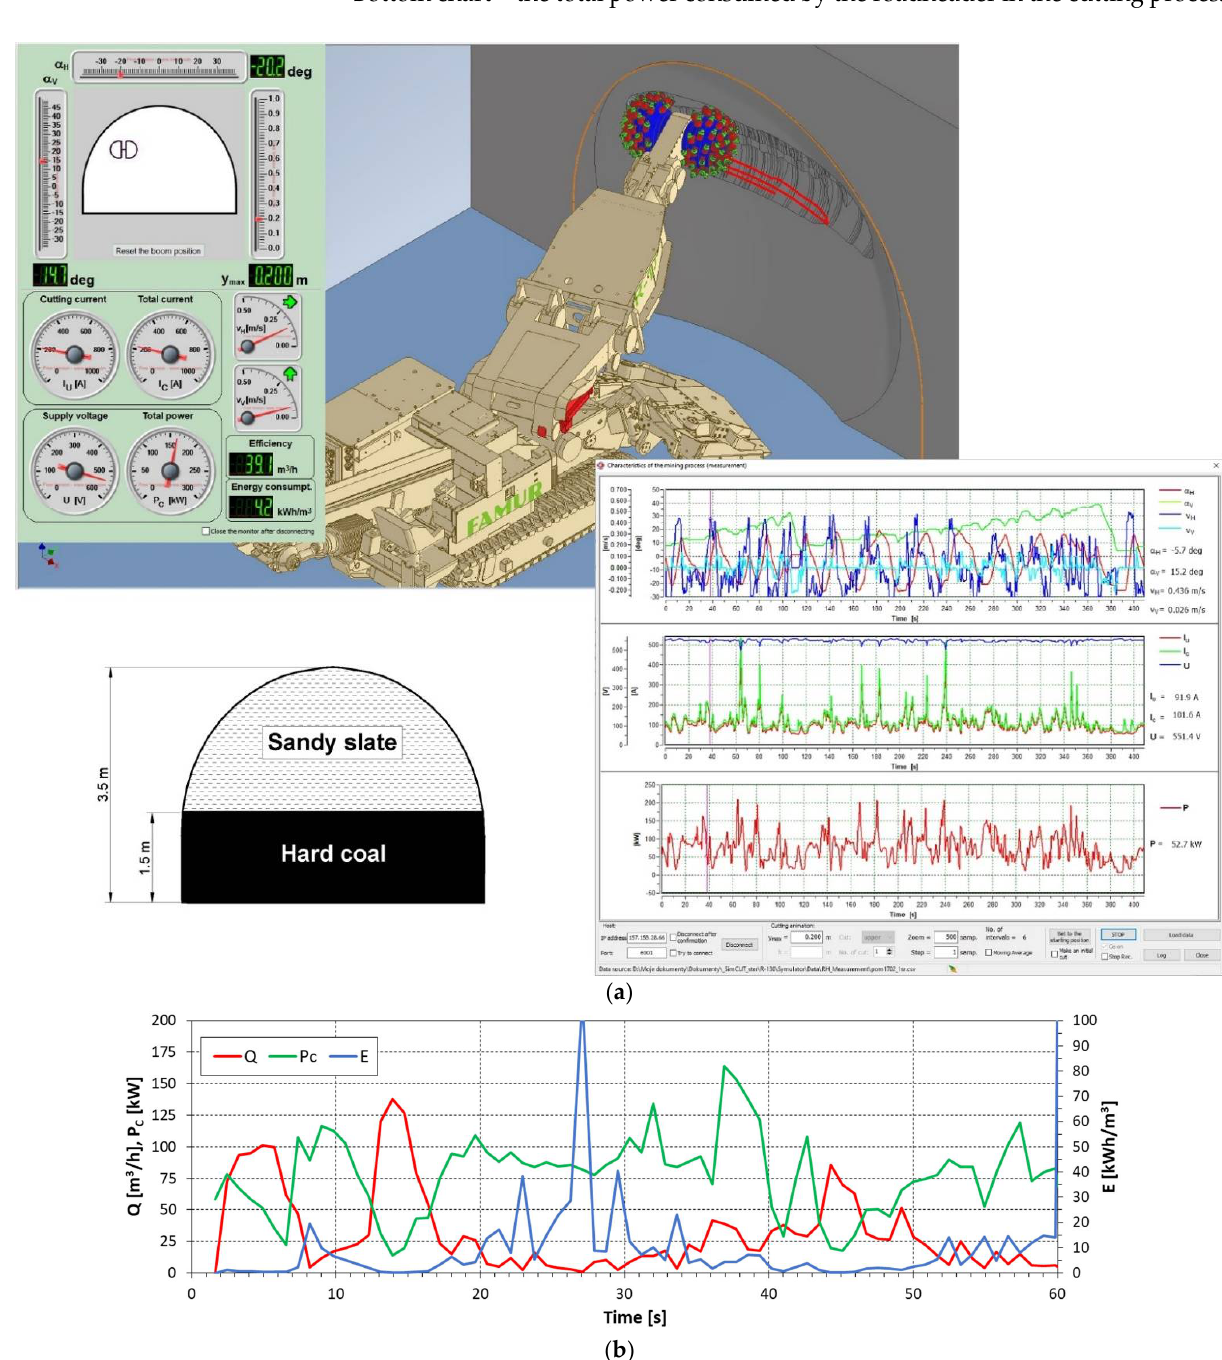
Figure 17. RH-Sim _research simulator in the real mining mode: ( a ) view of the Main Program window and the Data Processing Module, ( b ) a fragment of the course of the efficiency, power, and energy consumption of mining.